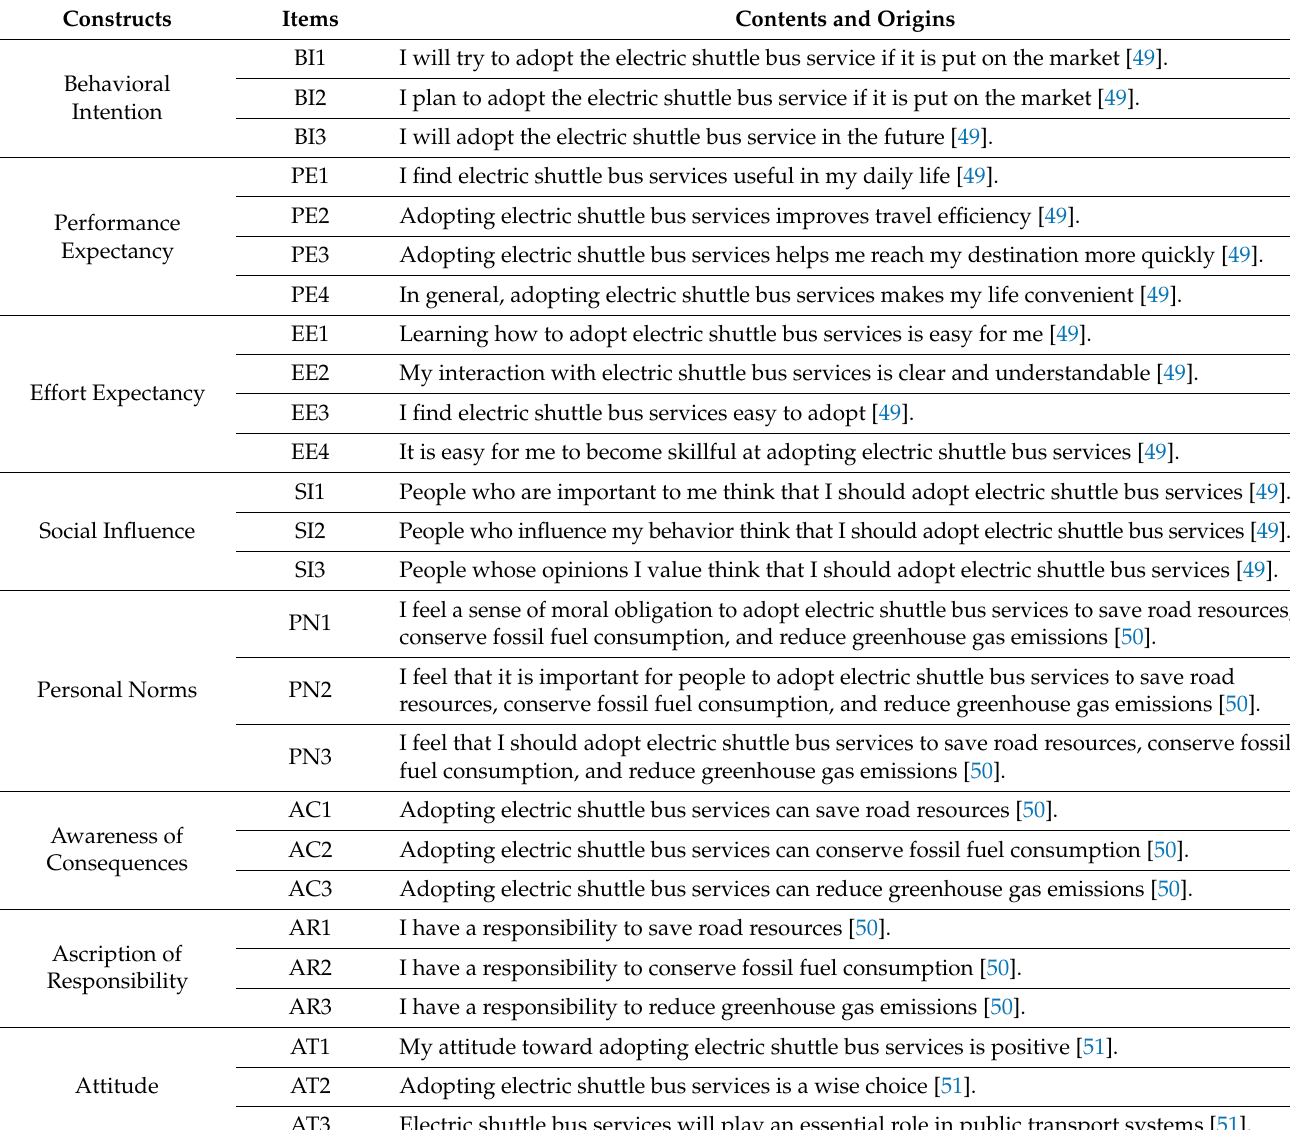
Table 1. The measurement items of each